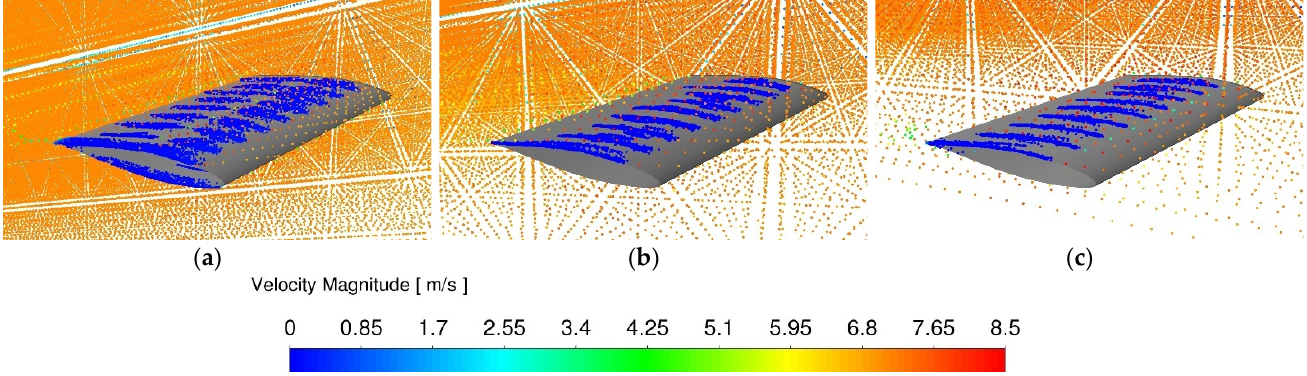
( c ) Figure 17. (a – c) Frames from the formation of water film over the wing during the two-phase flow experiment in the wind tunnel and the detachment of water from the trailing edge. 5. Discussion and Conclusions In this study, the design of a rectangular wing, based on an NACA 641-212 airfoil, was carried out with two different sizes of chord, 0.1 m (downscaled model) and 0.43 m (original model), and a constant aspect ratio 1.7. The aim of the research was to investigate whether a downscaled model simulation could offer us reliable results with less cost in terms of valuable computational resources and time.